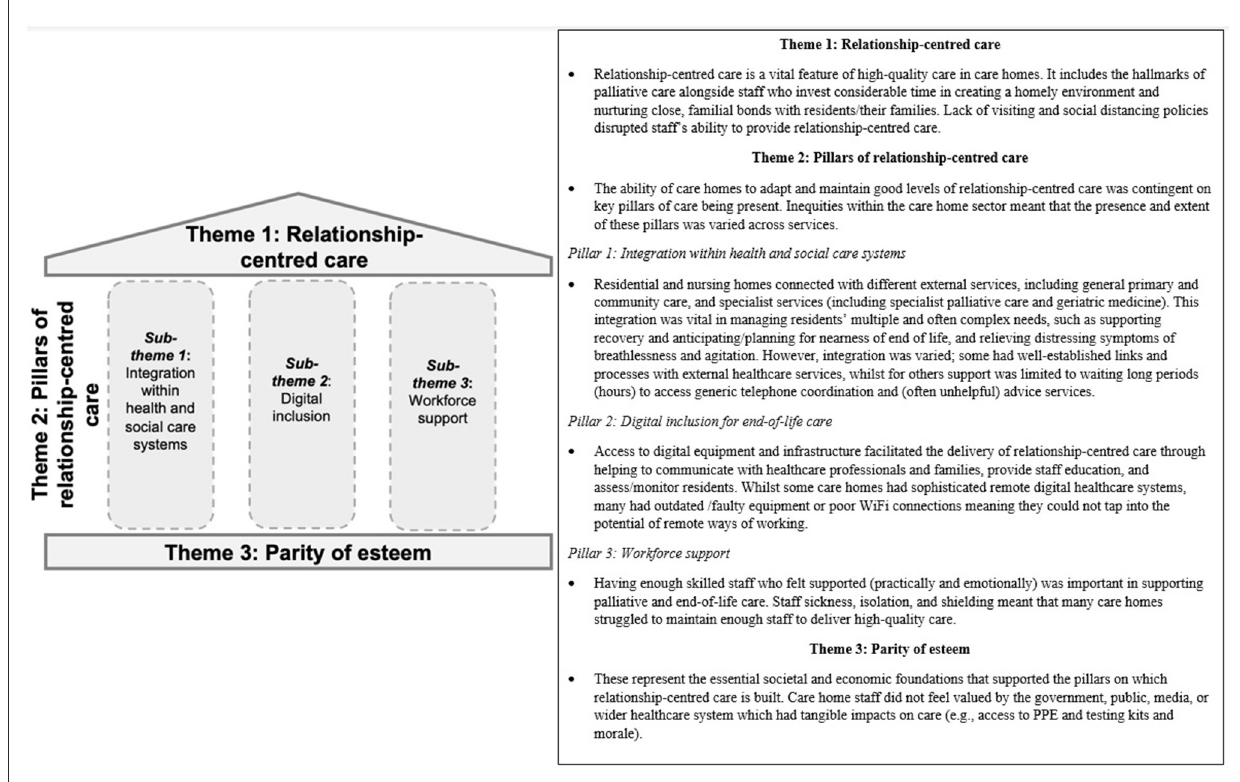
FIGURE2 Overview of integrated